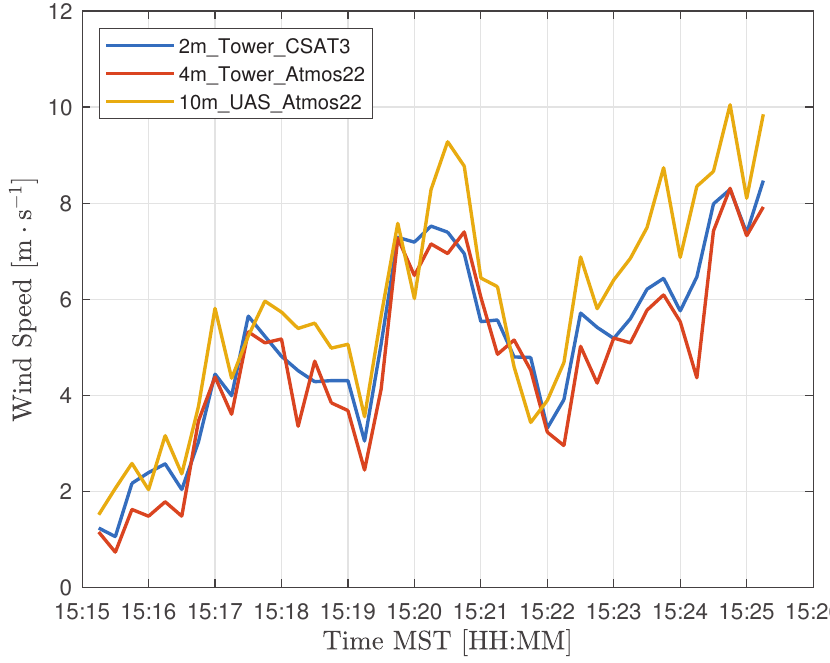
Figure 7. Comparison of wind speed measurements on the flux tower for a height of 2 m (CSAT3 sonic anemometer, yellow), 4 m (Atmos22 sonic anemometer), and 10 m (UAS with Atmos 22 sonic anemometer.